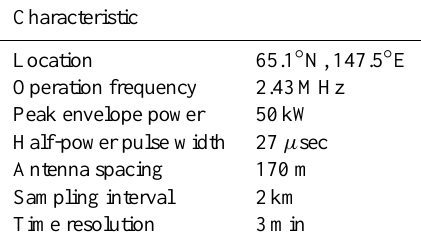
Table 1. Poker Flat MF radar system